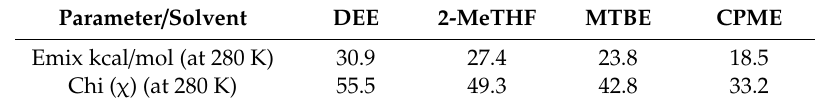
Table 2. Emix and Chi ( χ ) values of each ether and the CTC